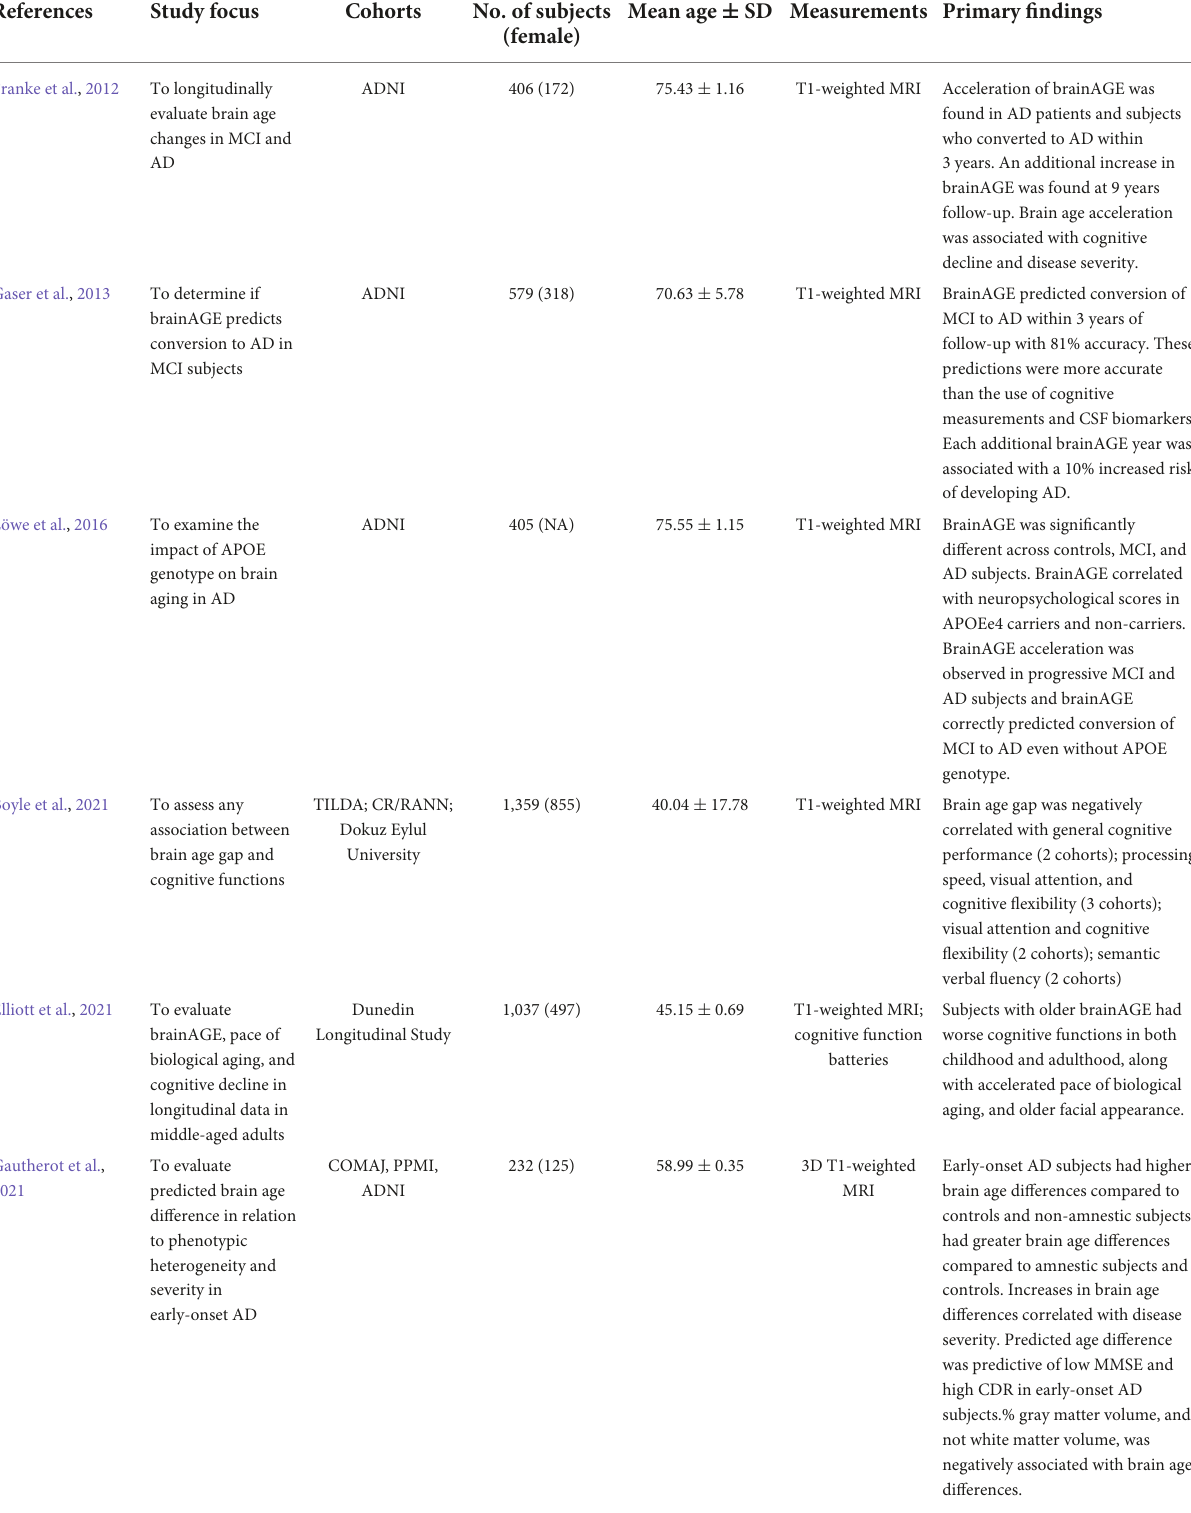
TABLE 1 Human brain age studies on cognitive functions, mild cognitive impairment (MCI), and/or Alzheimer’s disease